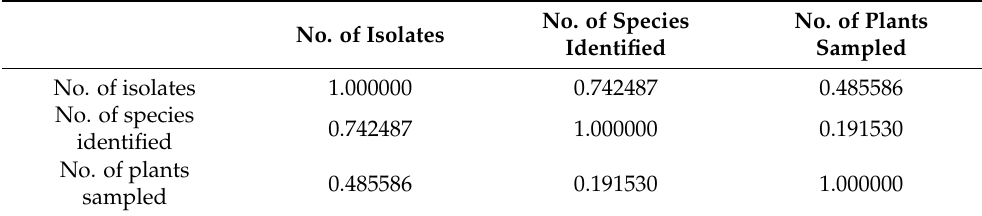
A correlation was found between the number of isolates and the number of species originating from the same farm (Spearman r = 0.74, p < 0.05, Table 4, Figure 1). The correlation between the number of sampled plants on each farm and the number of isolates was lower (r = 0.48, p < 0.05); the correlation between the number of sampled plants and the number of species found was even lower (r = 0.19, p < 0.05). Table 4. Spearman correlation coefficient r expressing the correlation between the numbers of isolates, species, and sampled plants in strawberry